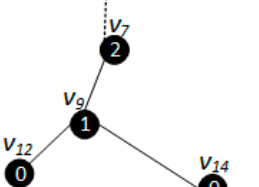
Figure 7. Broadcast backbone for LBAS.